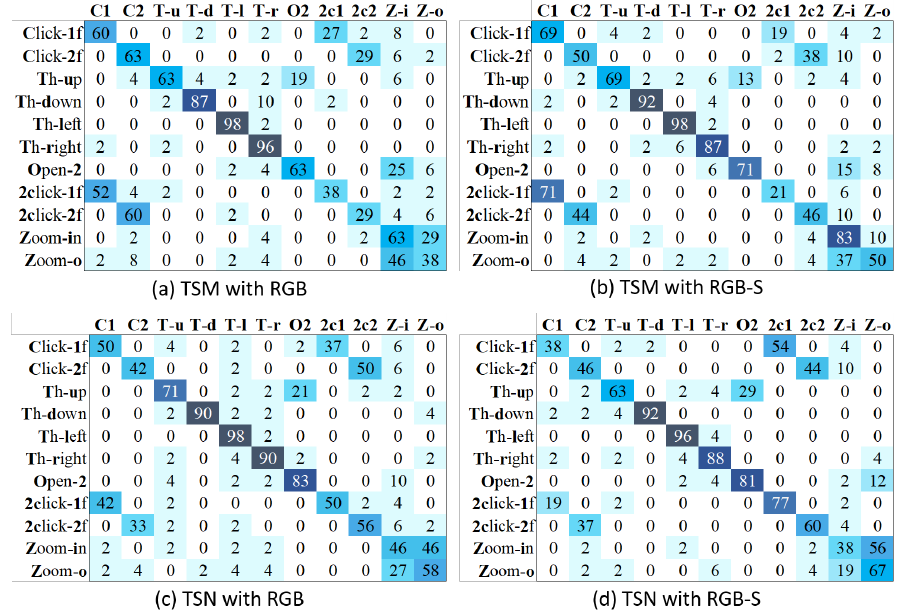
Figure 11. Confusion matrices of TSM and TSN with different input modalities, using action classes